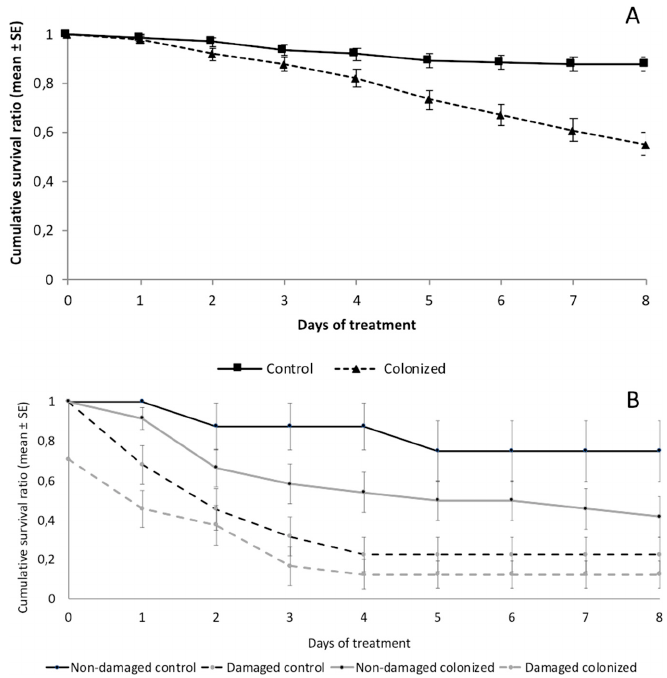
Figure 2. Cumulative survival ratio (mean ± SE) of S. littoralis larvae fed on ( A ) control (n = 120) and Metarhizium -colonized melon discs (n = 120), ( B ) control and Metarhizium -colonized plants in experiments with whole plants (non-damaged) (n control = 24, n colonized = 24) and plants damaged by tearing a non-treated leaf (damaged) (n control = 24, n colonized = 24).